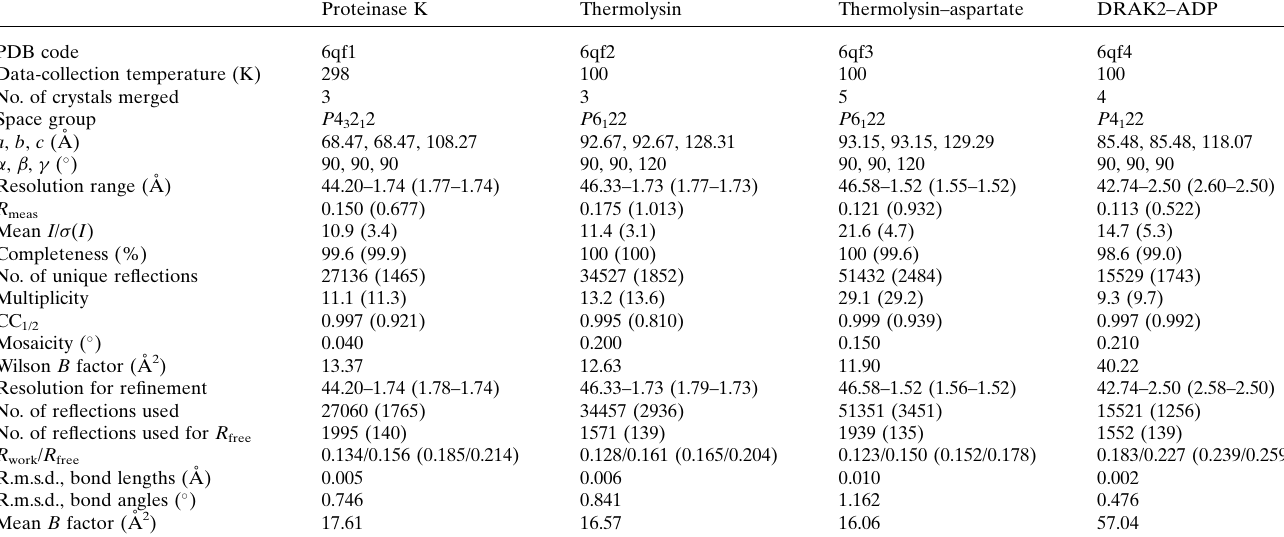
Table 2 Diffraction and refinement data statistics for proteins crystallized and soaked on Roadrunner I chips. Proteinase